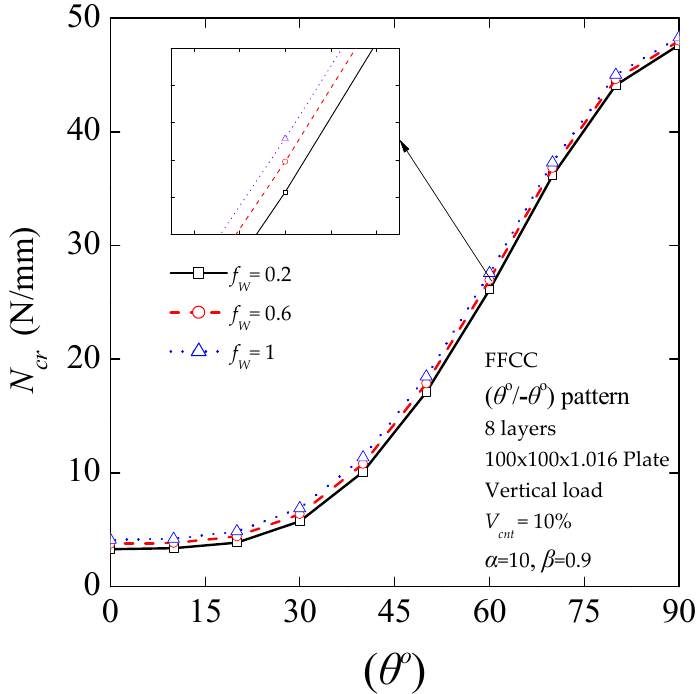
Figure 9. Critical buckling load as a function of fiber orientation angle for V cnt = 10% and various f W waviness factors.